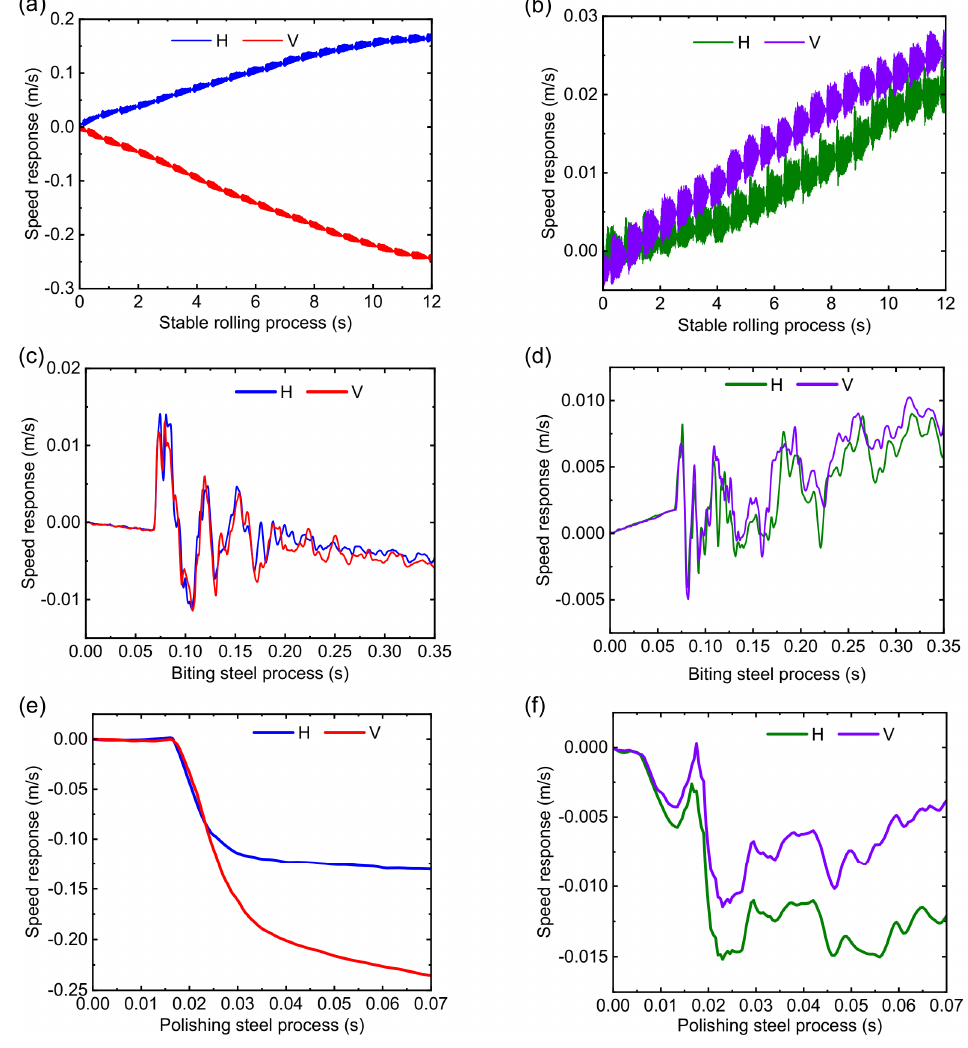
Figure 14. Transient speed response of the system when the finished weathering steel thickness is 1.6 and 3.2 mm: ( a ) stable rolling process of the 1.6 mm, ( b ) stable rolling process of the 3.2 mm, ( c ) biting steel process of the 1.6 mm, ( d ) biting steel process of the 3.2 mm, ( e ) polishing steel process of the 1.6 mm, and ( f ) polishing steel process of the 3.2 mm.